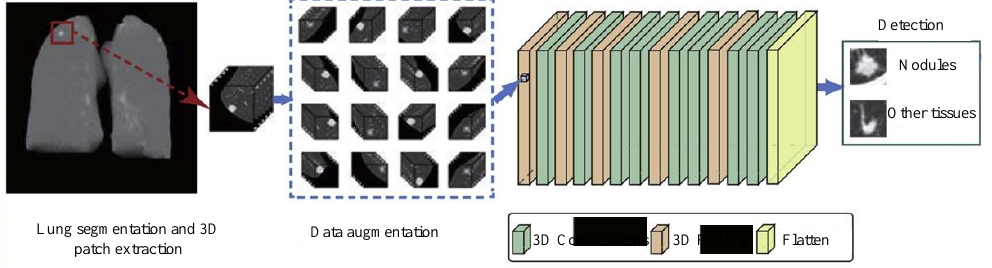
Figure 7. The basic procedure for lung nodule detection. The figure is modified from Reference [92].